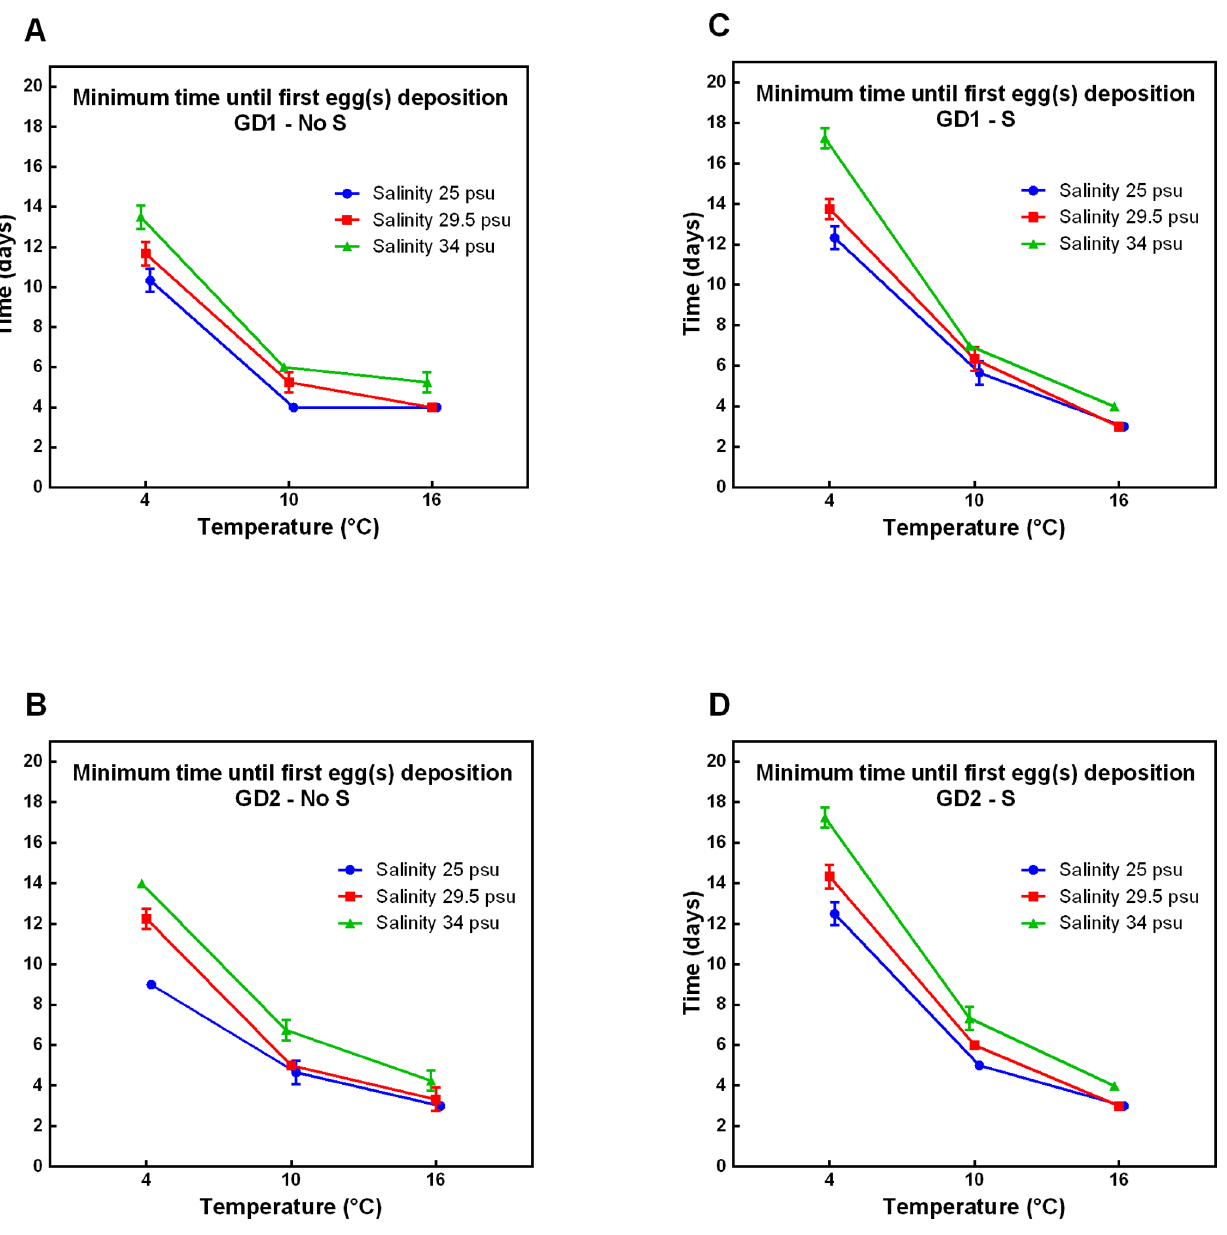
Figure 1. Minimum time until first egg(s) deposition of GD1 and GD2 under changing environmental conditions. Minimum time until first egg(s) deposition in relation to temperature and salinity of cryptic Halomonhystera disjuncta species: GD1 (A, C) and GD2 (B, D), in the absence (No S; A, B) and presence (S; C, D) of sulphide. The minimum egg deposition time corresponds to the day after the start of the experiment on which the first egg was observed within the experimental microcosms. Data shown are mean values 6 1stdev of 3 or 4 replicates per